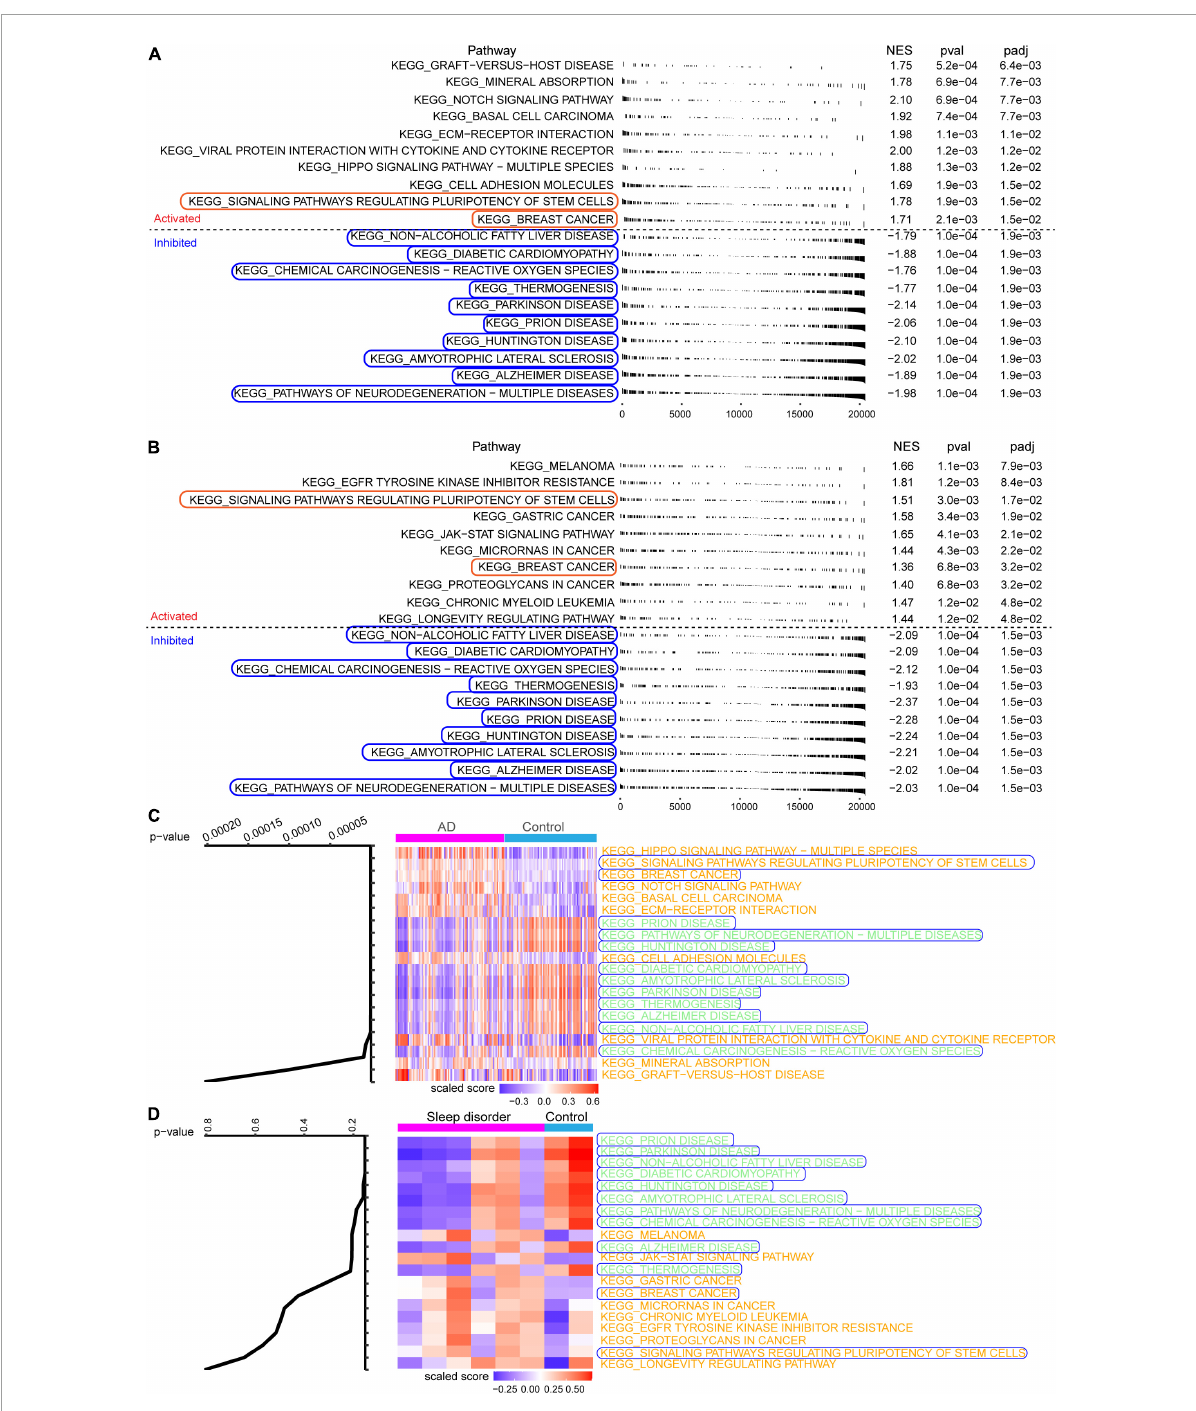
FIGURE3 Fast gene set enrichment analysis (fGSEA) and gene set variation analysis. Top 10 pathways significantly activated (red) or inhibited (blue) in the (A) GSE5281 or (B) GSE40562 dataset, based on fGSEA. (C,D) Heat map showing the Kyoto Encyclopedia of Genes and Genomes (KEGG) enrichment analysis in Alzheimer’s disease (AD), sleep disorder (fatal familial insomnia), and controls.